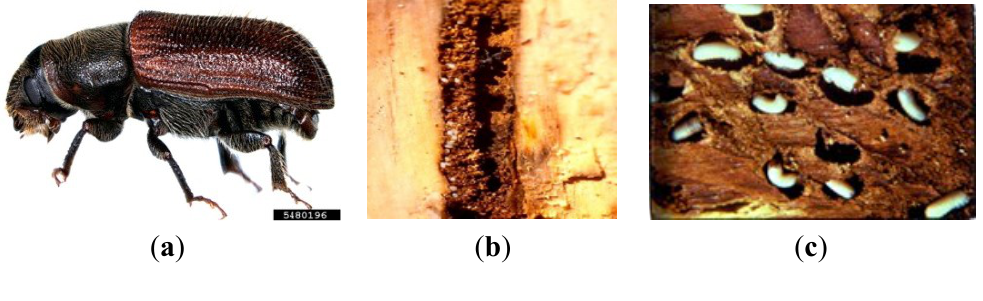
Figure 2. Spruce beetle adult ( a ) (Photo: Megan O‘Donnell and Andrew Cline, California Department of Food and Agriculture, Bugwood.org); spruce beetle eggs ( b ) (Photo: A. Steven Munson); spruce beetle larvae and pupae ( c ) (Photo: A. Steven